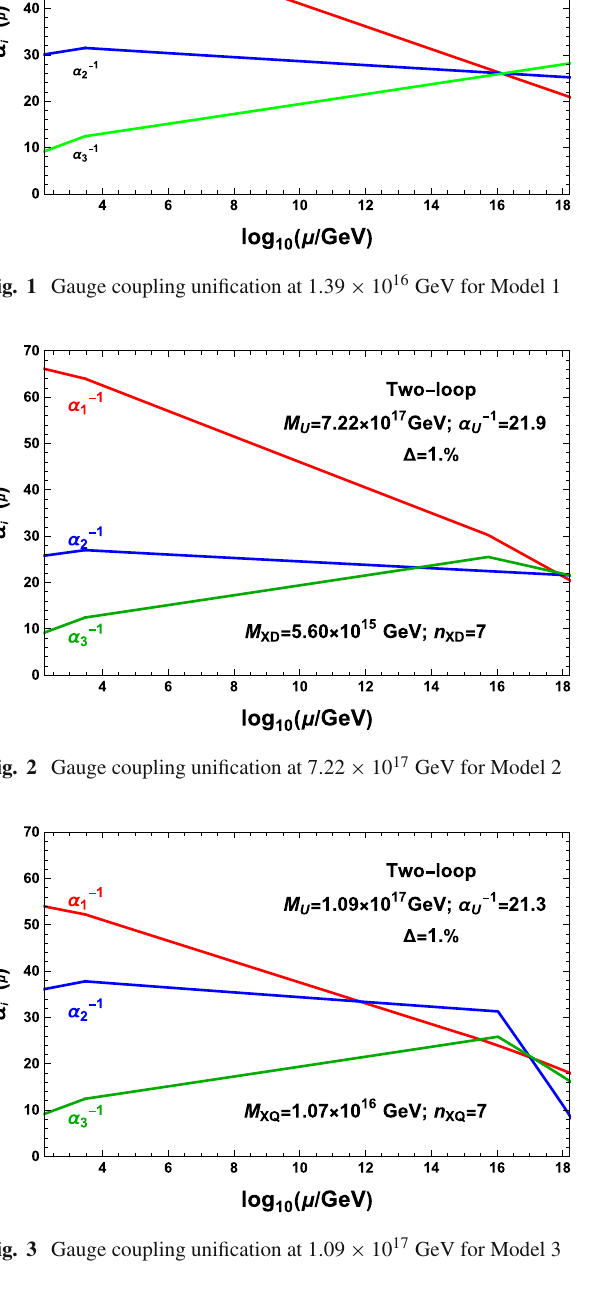
X Q ) in Model 3 with k Y = 175 / 96 , k 2 = 5 / 6, we achieve gauge coupling unification at around string scale 1 . 09 × 10 17 GeV, which we show in Fig. 3. The masses of the extra vector-like particles for Model